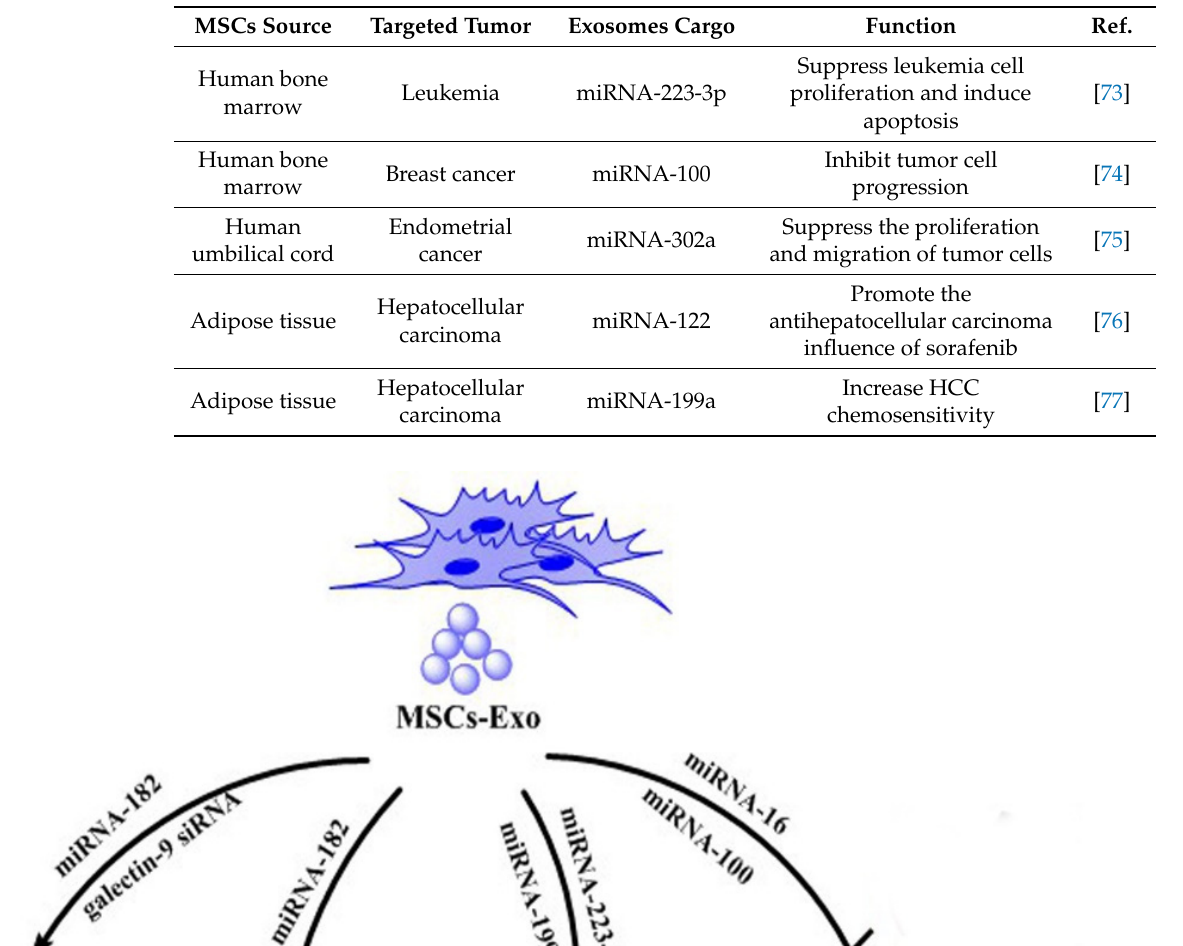
Table 3. Suppression function of MSCs-Exo.